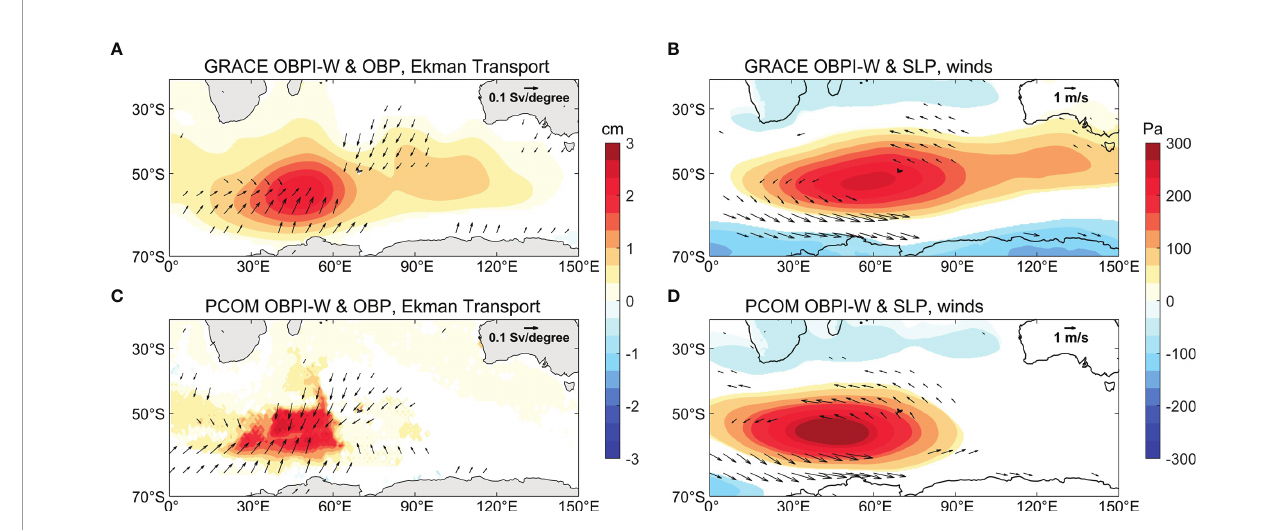
FIGURE 12 | Regression coef fi cients of OBP anomalies (color) and Ekman transports (vector) on the (A) normalized GRACE OBPI-W and (C) normalized PCOM OBPI-W. (B, D) are identical to (A, C) but for SLP anomalies (color) and 10 m winds (vector). Only anomalies that are signi fi cant at the 95% signi fi cance level are